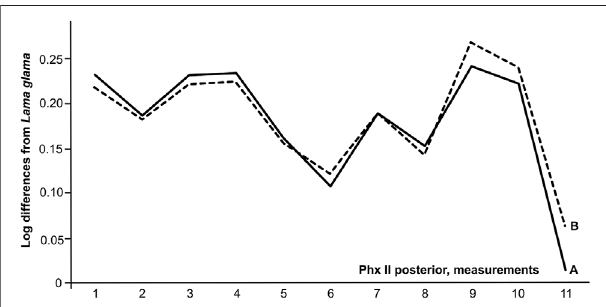
FIGURE 4 | Ratio diagrams of posterior second phalanges of Camelus from Mongolia: 1 – Tugrug Shireet; 2 – C. bactrianus ( n = 6). Measurements: 1 - anterior length; 2 - posterior length; 3 - middle articular length; 4 - minimal articularlength;5-breadthoftheupperepiphysis;6-depthoftheupper epiphysis; 7 - breadth of the diaphysis; 8 - depth of the diaphysis; 9 - greatest lower breadth; 10 - minimum breadth of the lower epiphysis; 11 - depth of the lower